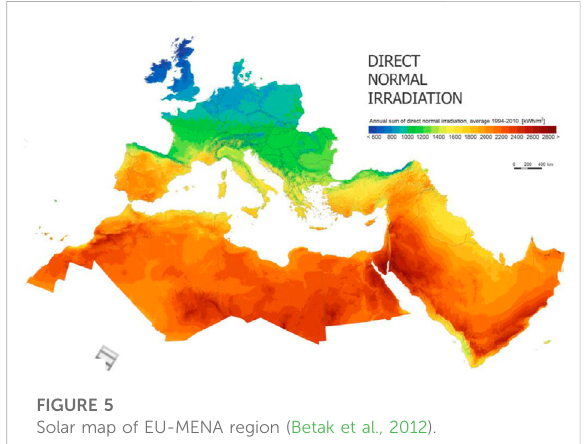
FIGURE 5 Solar map of EU-MENA region (Betak et al.,